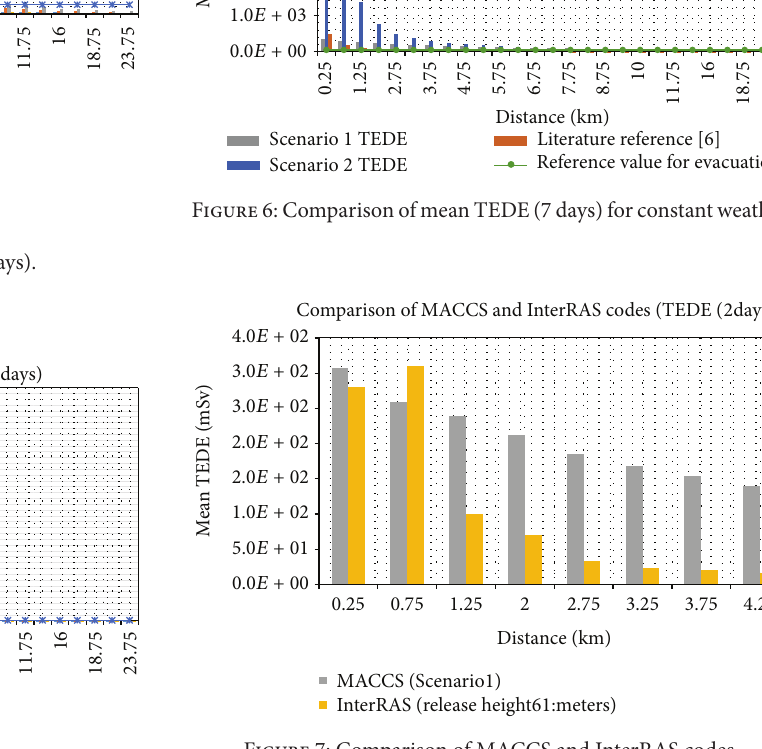
Figure 7: Comparison of MACCS and InterRAS